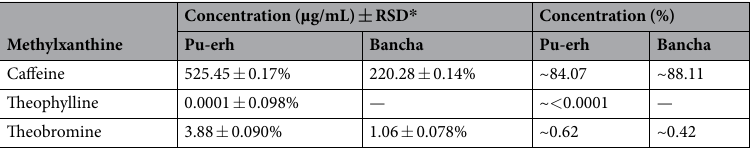
Table 1. Determined concentrations of caffeine, theophylline and theobromine in the methylxanthine fractions isolated from Pu-erh and Bancha tea leaves and their approximate percentage. For calculation of the concentrations were used six samples. * RSD – relative standard deviation. —Below the quantification